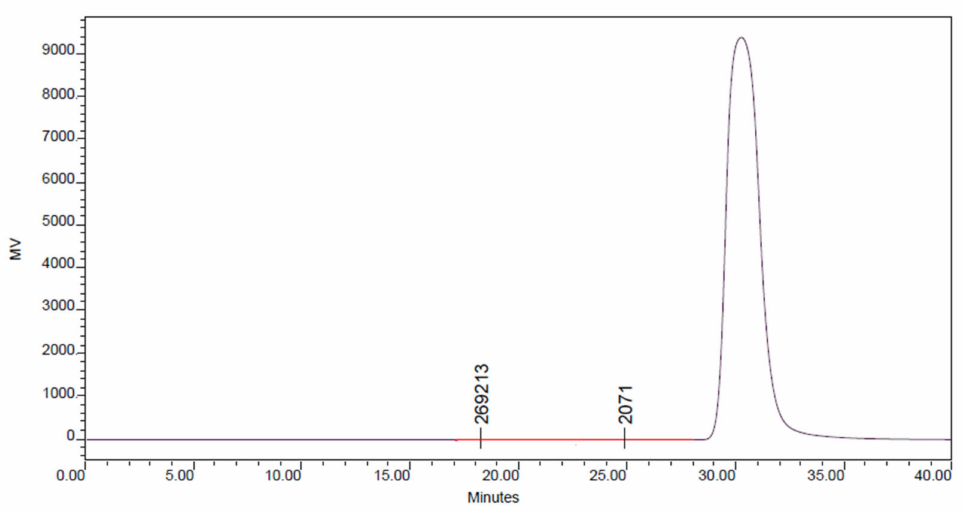
Figure 8. Distribution of Molecular Weight of